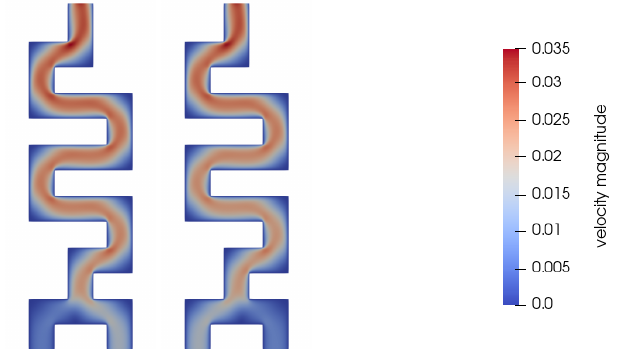
Figure 9. Flow velocity magnitude on a horizontal slice through the center of the channel. With composite cosine pulsation, at t = 7.4 s ( left ) and t = 7.8 s ( right